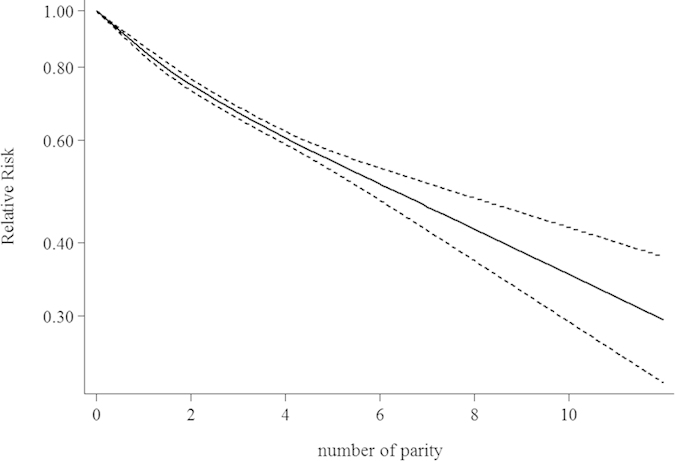
Nonlinear dose-response relationship between number of parity and endometrial cancer risk.The solid line represents the estimated relationship. The dashed line represents the 95% confidence interval of the estimated relationship.